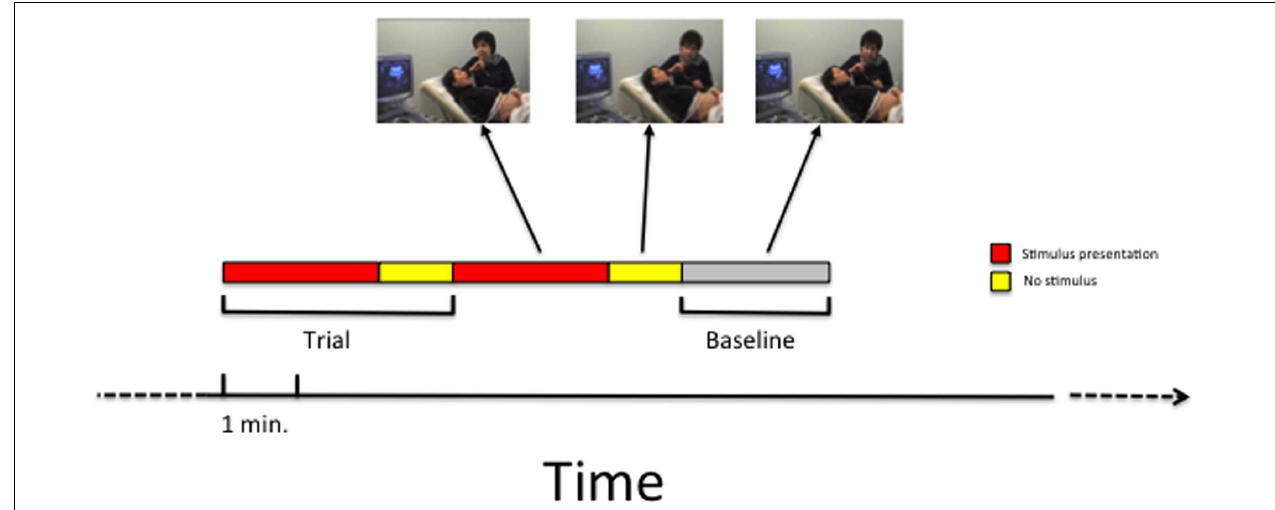
FIGURE 2 | A schematic illustration of the time sequence of trials and baseline that was employed in the study.